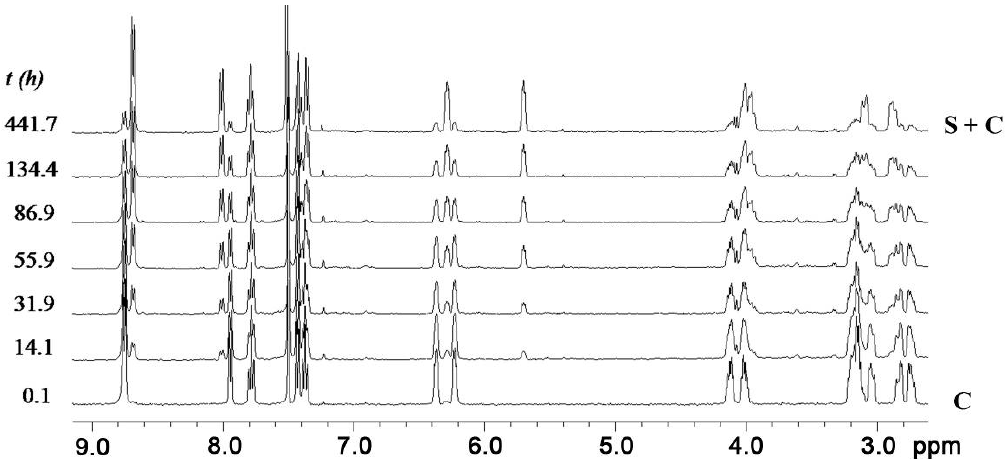
) and for the switching C → S